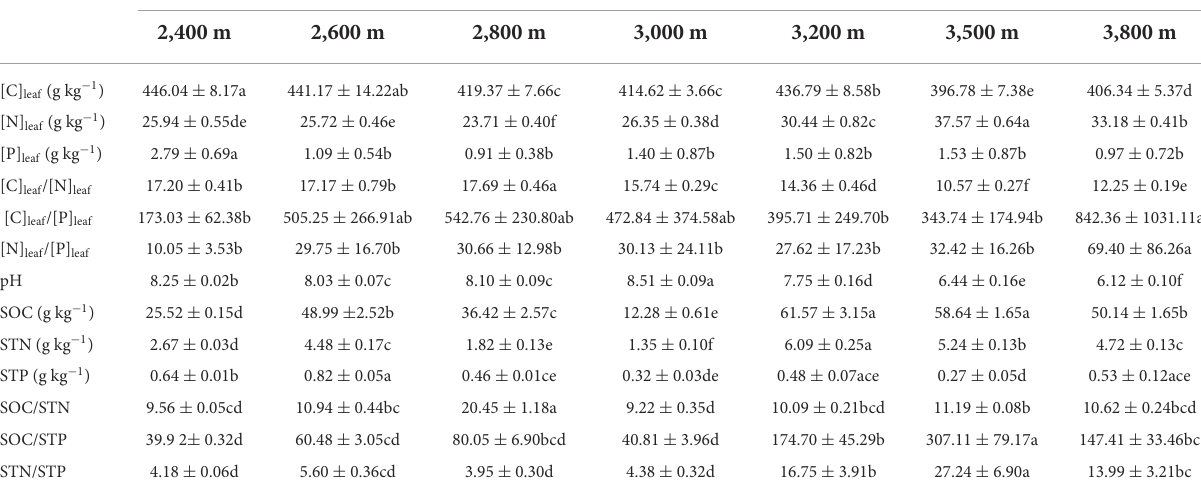
TABLE 3 Variation of leaf stoichiometry of Potentilla anserina and soil properties (0–0.40m) across elevations (mean ± standard error, n = 9).